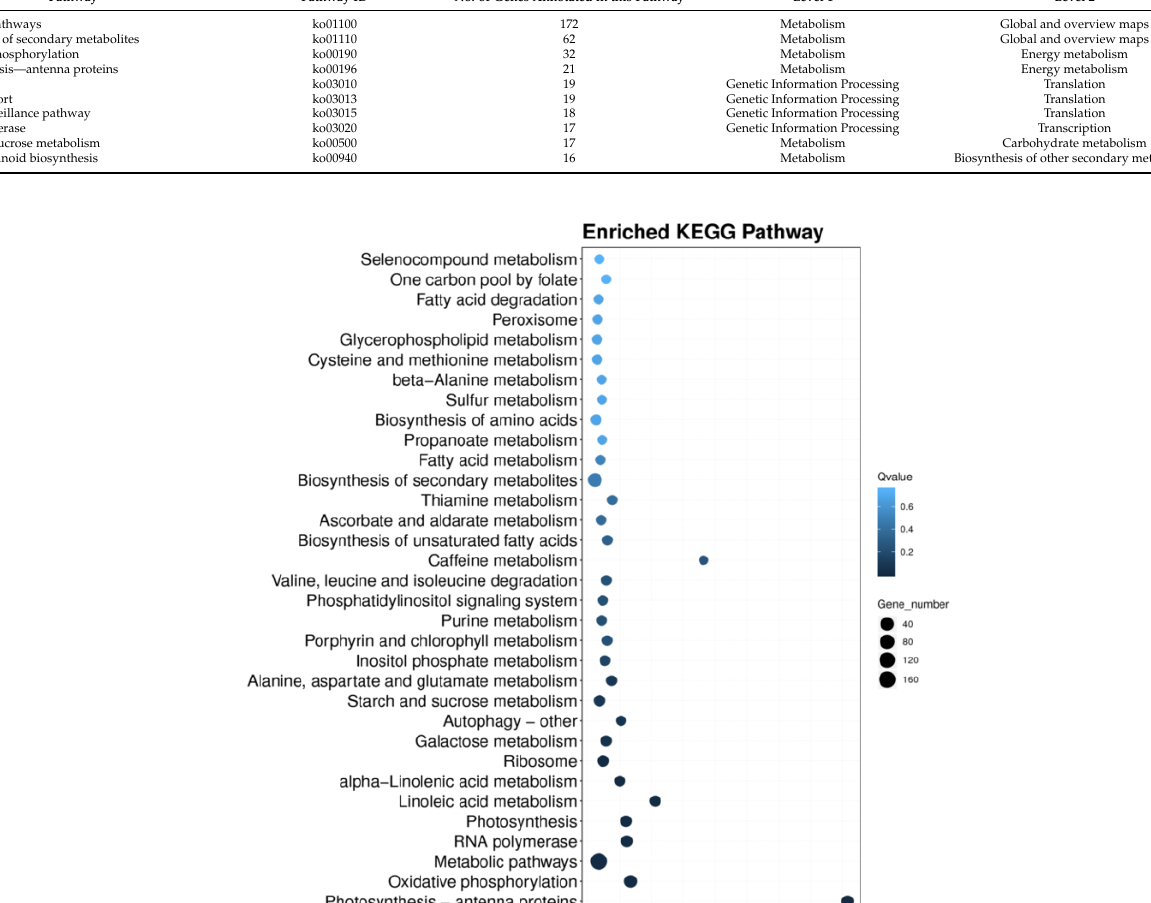
Table 4. Significant 15 KEGG pathways based on genes differentially expressed in high-B (TB 10 mM)-treated shoots of the T. dicoccum (Td) genotype, PI94655 compared to 3.1 µM B (control) treat- ment.